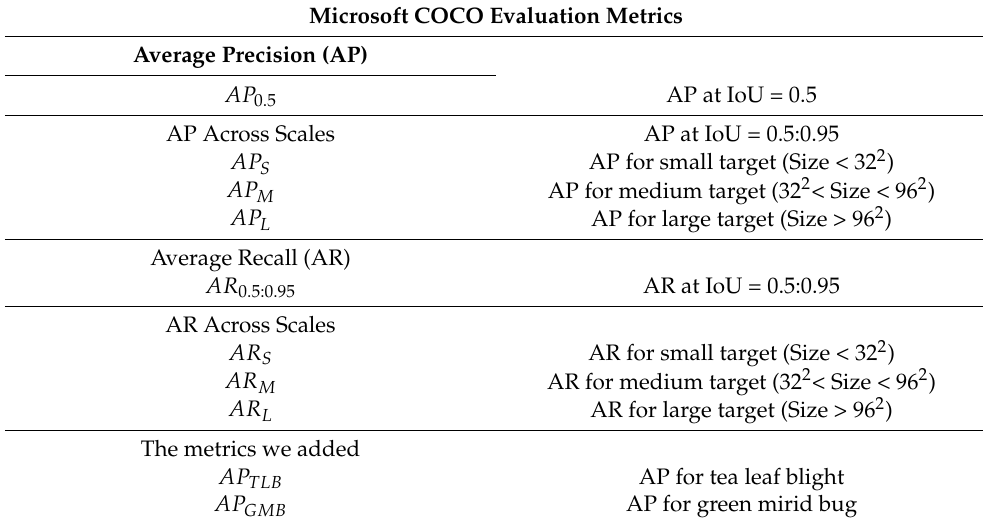
Table 2. Microsoft COCO evaluation metrics and the metrics we